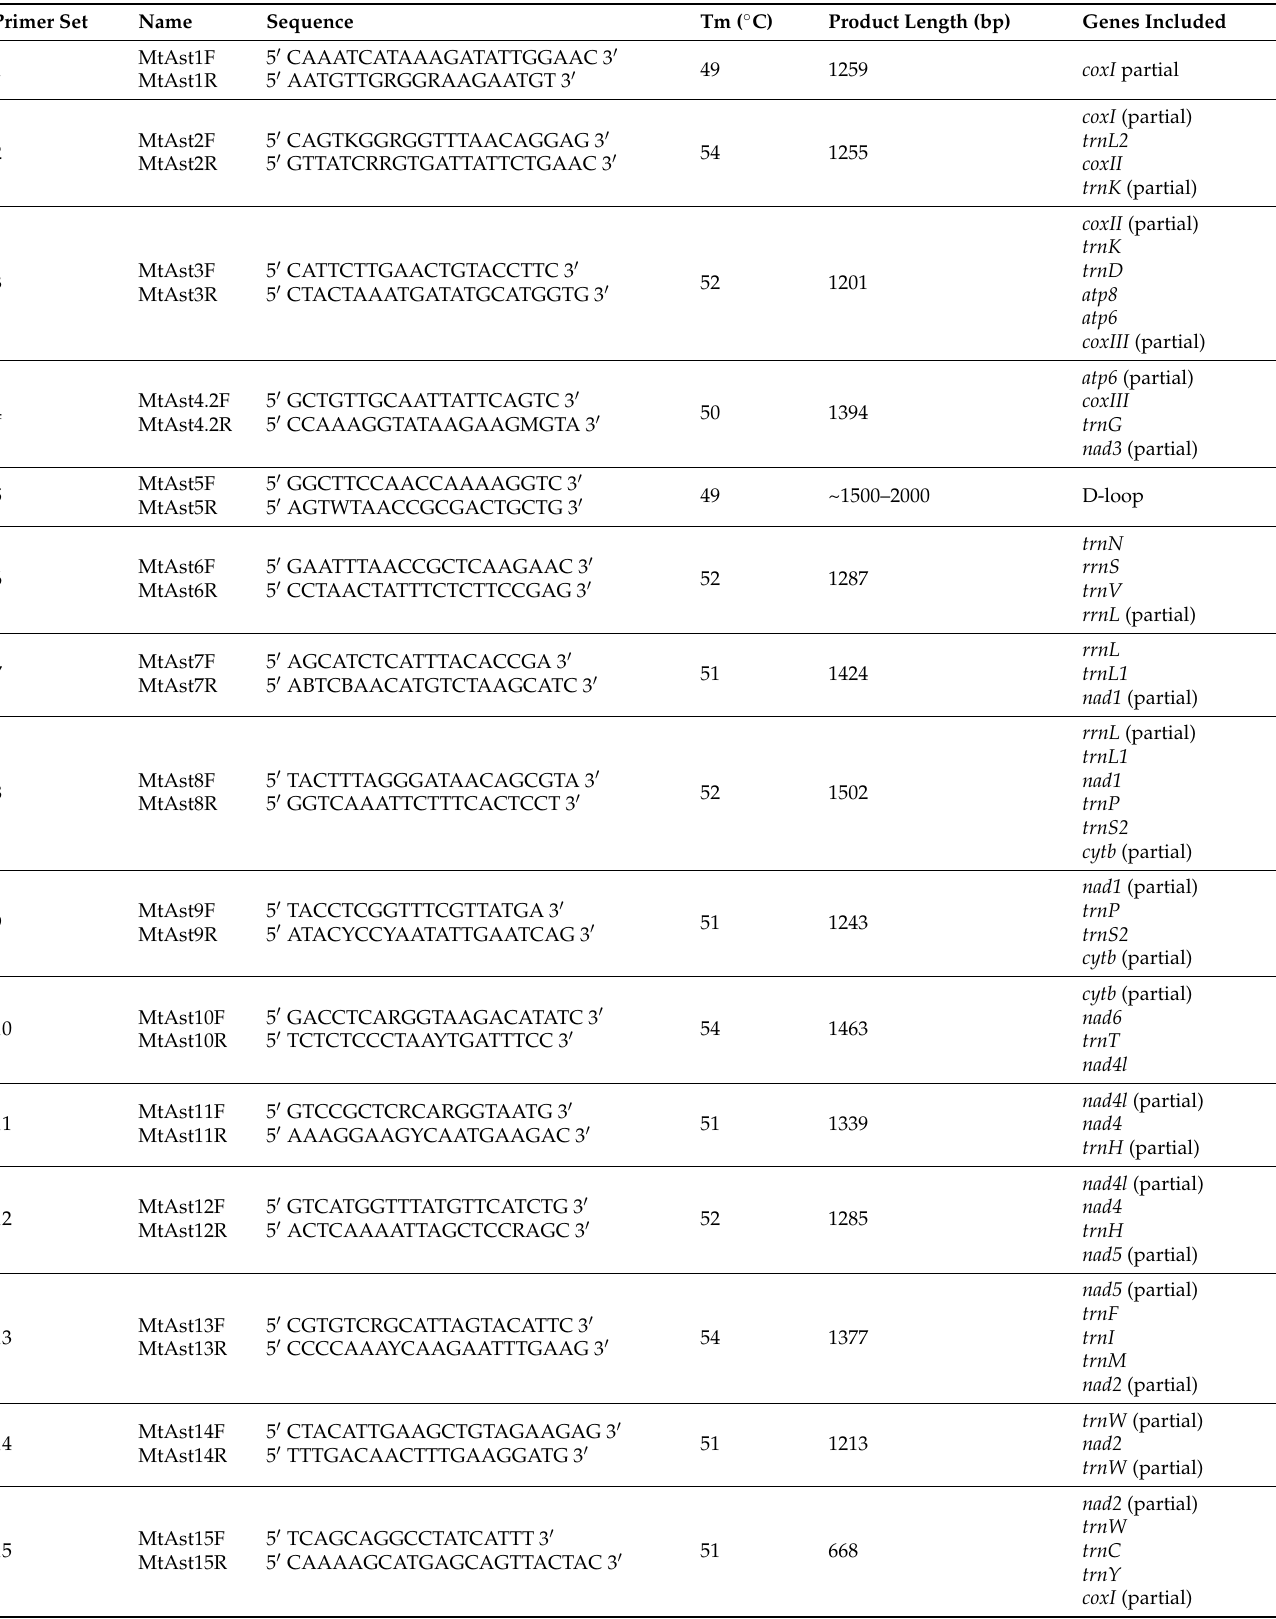
Table 1. Primer sets designed for the sequencing of mtDNA of Pontastacus leptodactylus